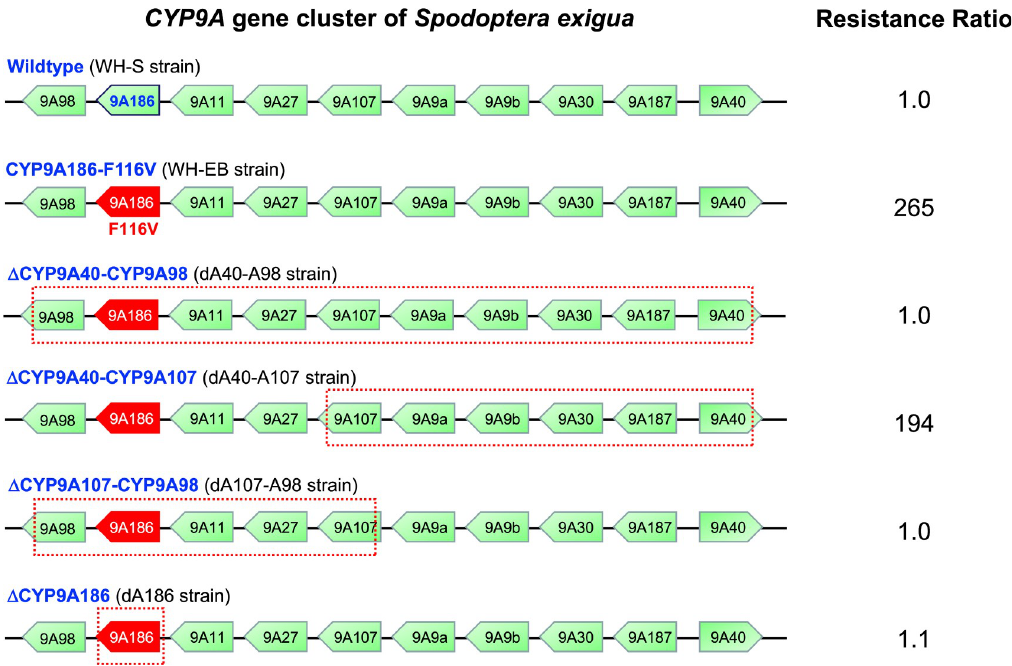
Fig 3. Genome mapping of the CYP9A gene cluster by CRISPR/Cas9 gene editing. Deletions in the CYP9A gene cluster are indicated with dotted boxes and include Δ CYP9A40-CYP9A98, Δ CYP9A40-CYP9A107, Δ CYP9A107-CYP9A98, and Δ CYP9A186. Resistance ratios to EB for each of the homozygous strains harboring both the natural CYP9A186-F116V mutation in resistant WH-EB strain and the CRISPR/Cas9-edited strains are shown.